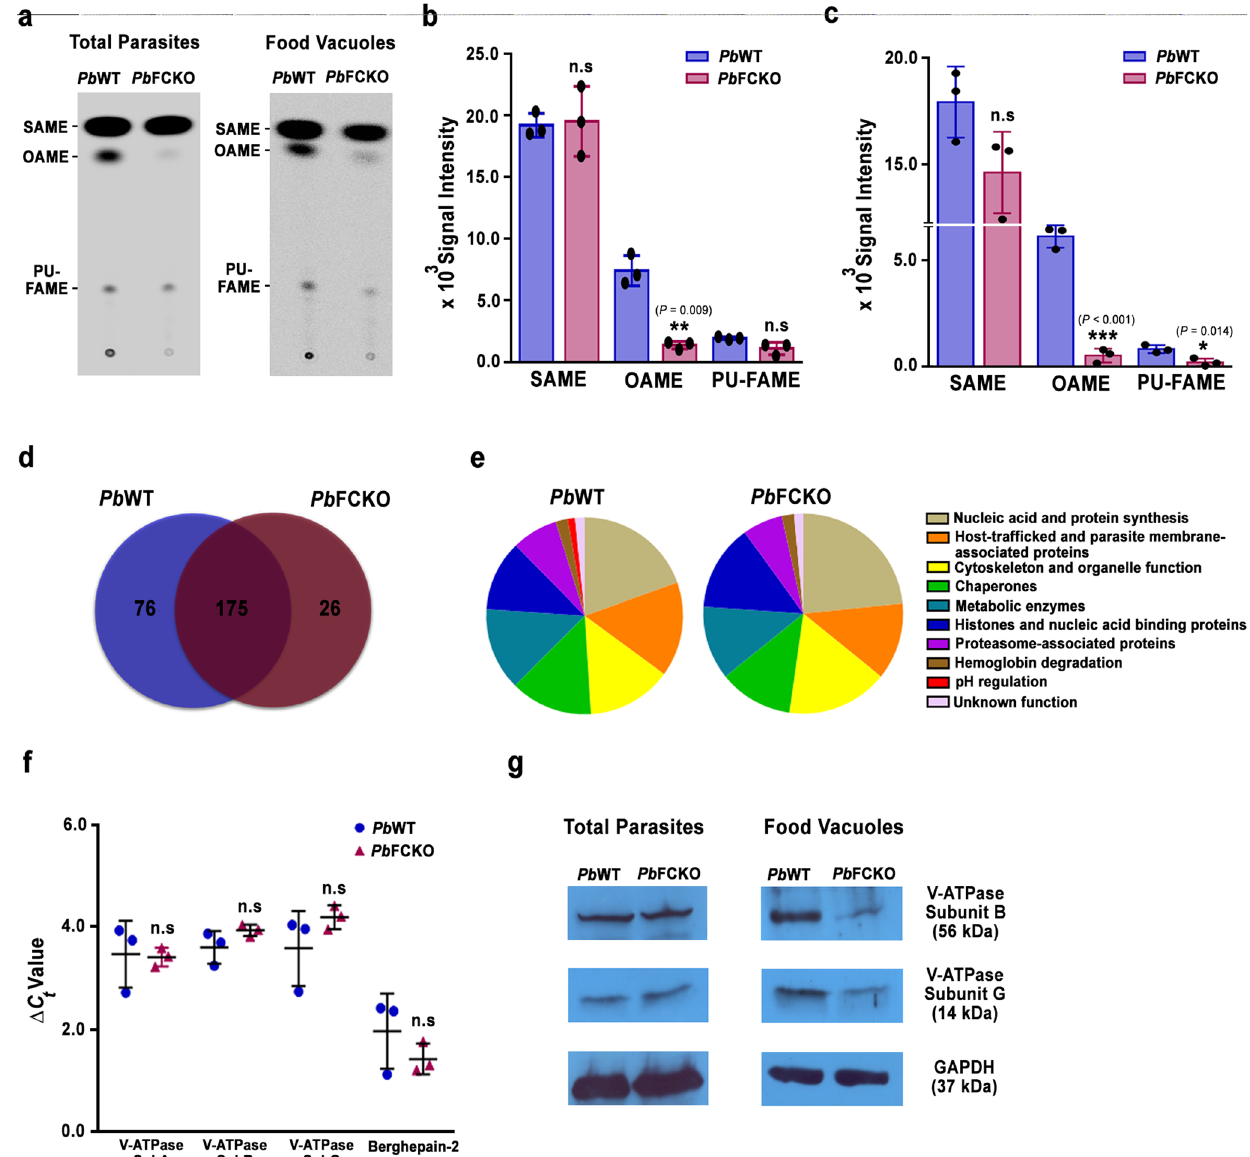
Fig. 8 Evaluation of OA synthesis and FV proteomics for WT and FCKO parasites. a TLC separation of 14 C-SA radiolabelled unsaturated FAMEs for Pb WT and Pb FCKO total parasites and FVs. One third of the FAME preparation used for total parasites and entire preparation used for FVs. b , c Band intensities quanti fi ed for total parasites and FVs, respectively (mean ± SD; n.s not signi fi cant, * P < 0.05, ** P < 0.01, *** P < 0.001, unpaired t -test; two-sided), from three different experiments. Individual data points are shown as black circles. d Venn diagram of total proteins identi fi ed in the Pb WT and Pb FCKO FVs. e Functional classi fi cation of the proteins based on gene ontologies available at PlasmoDB and UniProt databases. Supplementary Data 1 and Supplementary Data 2 have the complete set of details related to Pb WT and Pb FCKO FV proteome analyses. Three different FV preparations of Pb WT and Pb FCKO were pooled independently to get adequate amount of protein for the proteomics analyses. f qPCR analysis of RNA transcripts. The Δ C t values obtained with respect to parasite GAPDH were plotted (mean ± SD; n.s not signi fi cant, unpaired t -test; two-sided). The data represent three different preparations of RNA from WT and FCKO parasites. g Western analysis of V-type H + ATPase subunits. The total parasite preparations represent parasite pellets pooled from two different mice. For FVs, three different FV pellets were pooled separately for WT and FCKO. These preparations were independent of those that were used for proteomics analysis. GAPDH is known to be present in FVs and therefore, used as a control for total parasite and FV preparations. ( n = 2 independent experiments). Full-length blots are provided in the Supplementary Fig. 7. Source data are provided as a Source Data fi